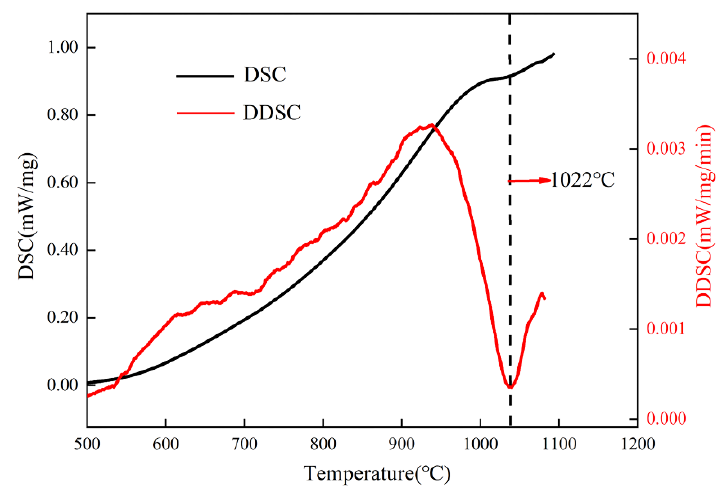
Figure 1. The measured DSC/DDSC curve of the as-built TA15 sample.